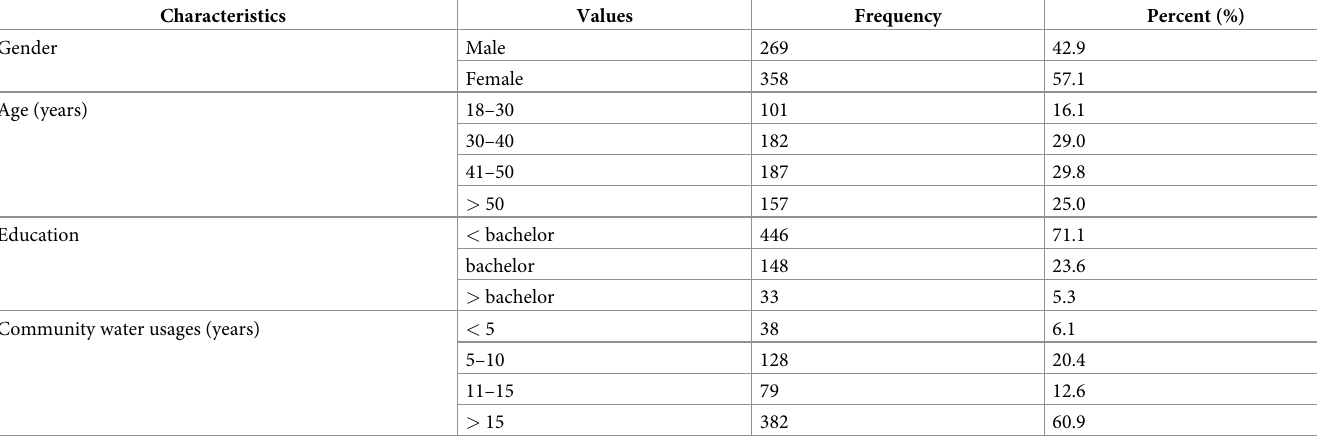
Table 1. Demographic data of respondents, total (N =